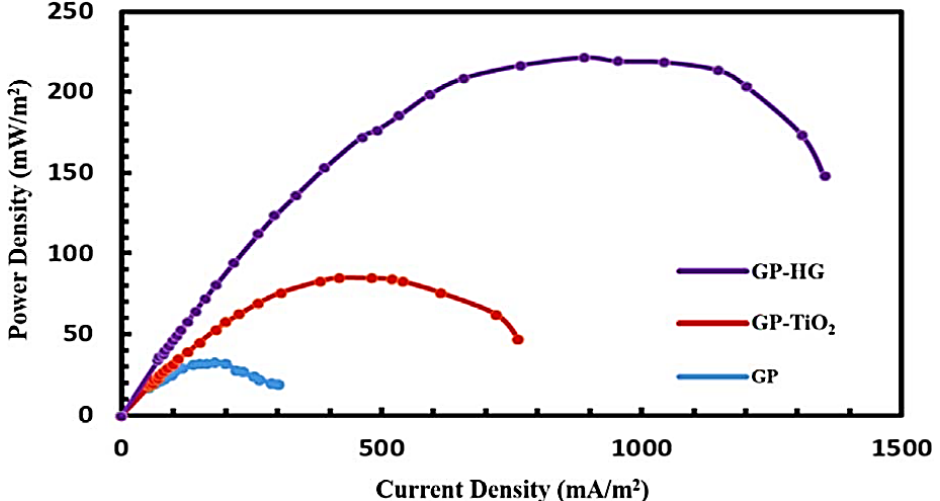
Figure 4. Power output curves (batch mode) of graphite paste (GP), graphite paste–titanium dioxide (GP-TiO 2 ), or graphite paste–hybrid graphene (GP-HG) cathodes [83]. Reproduced with permission from Elsevier. Table 1. Specifications of green nanocomposites for microbial fuel cell